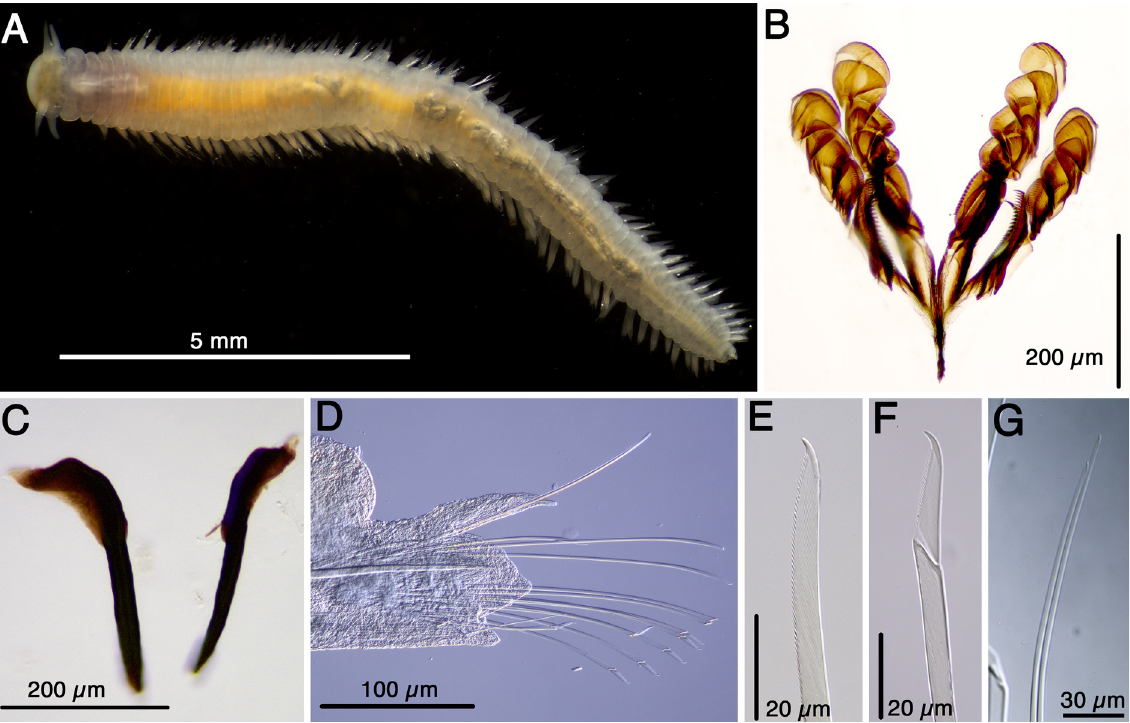
Fig. 8. Ophryotrocha pruittae sp. nov. A . Dorsal view of living holotype (ICML-EMU-13288). B . Maxillae from paratype (SIO-BIC A14123). C . Mandibles from paratype (SIO-BIC A14123). D . Parapodium from paratype (SIO-BIC A6322). E . Simple supra-acicular chaetae from paratype (SIO- BIC A6322). F . Compound sub-acicular chaetae from paratype (SIO-BIC A6322). G . Simple sub- acicular chaetae of paratype (SIO-BIC